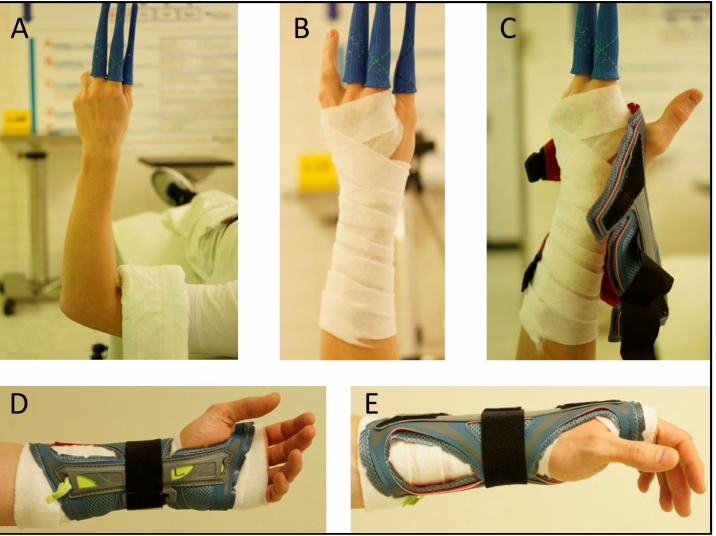
Figure 3. Orthosis application procedure: ( A ) Hanging in extension, ( B ) Cotton-wool padding, ( C ) Placement of the orthosis in suspension, ( D , E ) Correct placement of the